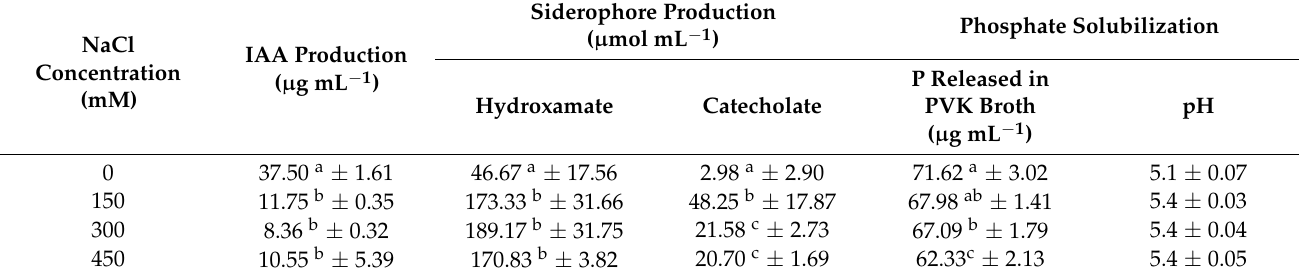
Table 1. Plant growth promoting activity of D. abyssi MT1.1 T under different level of salt